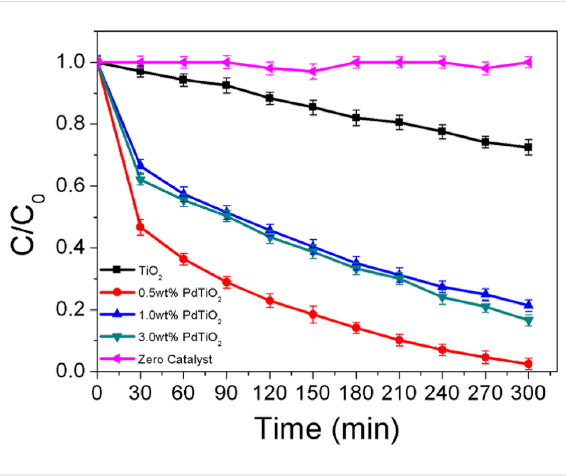
Figure 9: Photocatalytic degradation rates of AMX under visible light